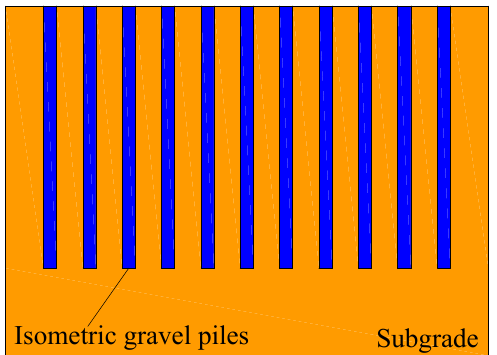
Figure 1. Isometric gravel piles.